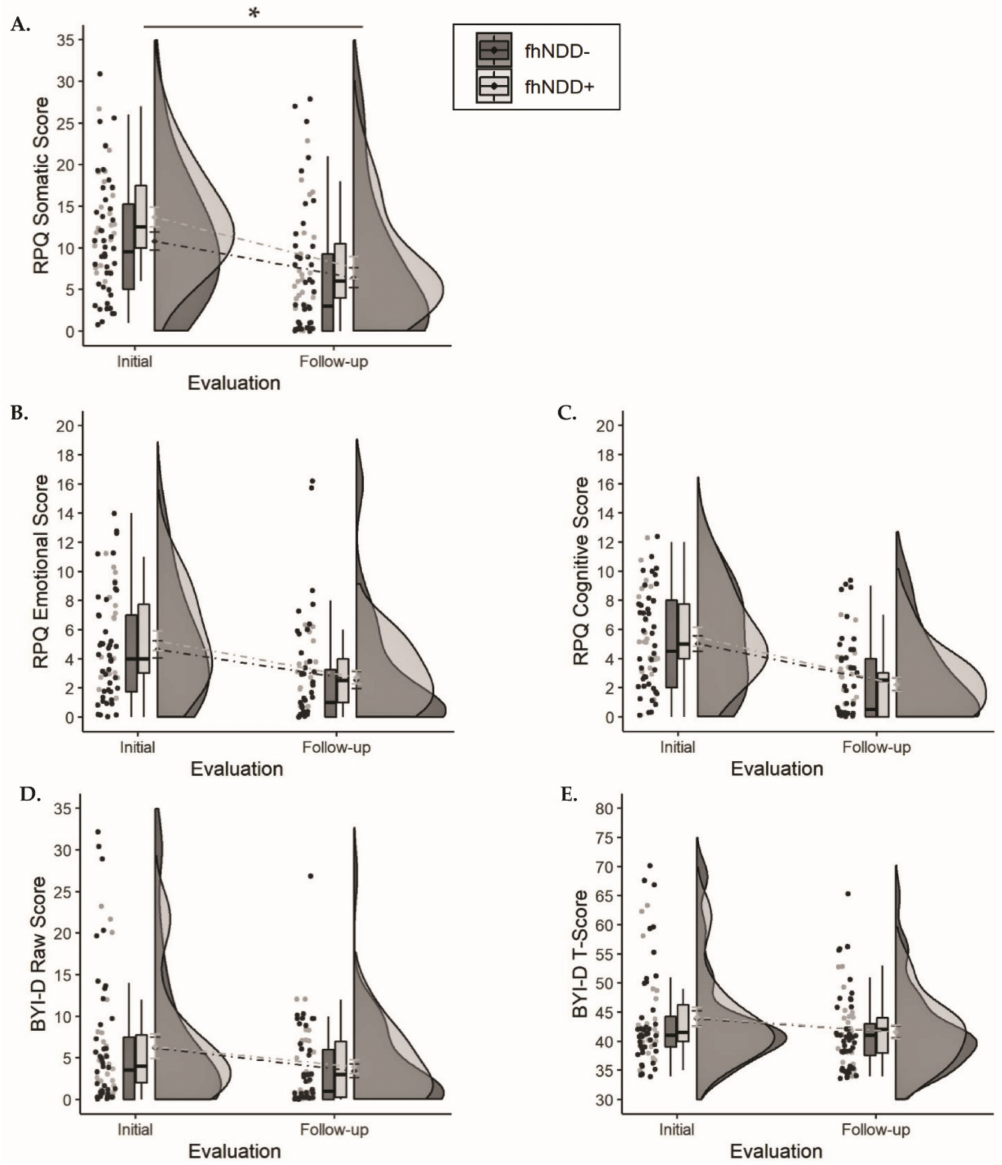
Figure 3. Group comparisons of symptom questionnaires between those with a family history of neurodegenerative disease (fhNDD+; light gray) and without a family history of neurodegenerative disease (fhNDD − ; dark gray). ( A ) RPQ somatic score. ( B ) RPQ emotional score. ( C ) RPQ cognitive score. ( D ) BYI-D raw score. ( E ) BYI-D t -score. * p <